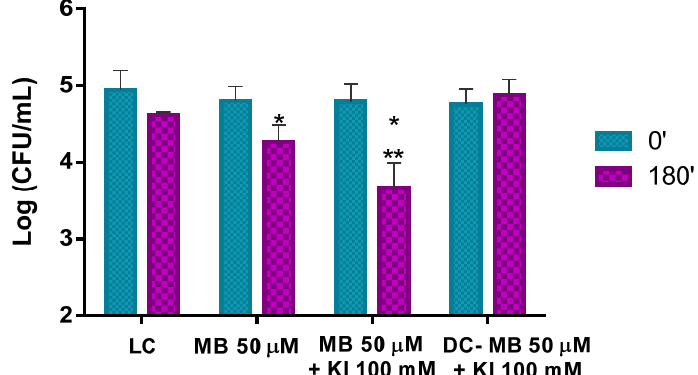
Figure 8. Ex vivo aPDT assay of pollen natural microorganisms, irradiated with 50 mW cm − 2 for 180 min, using MB at 50 μ M and MB at 50 μ M with the addition of KI (at 100 mM). Values represent the mean of three independent assays; error bars represent the standard deviation. * p < 0.05 (relative to each condition at time 0 ′ ); ** p < 0.05 (relative to MB). LC, light control; DC, dark control.